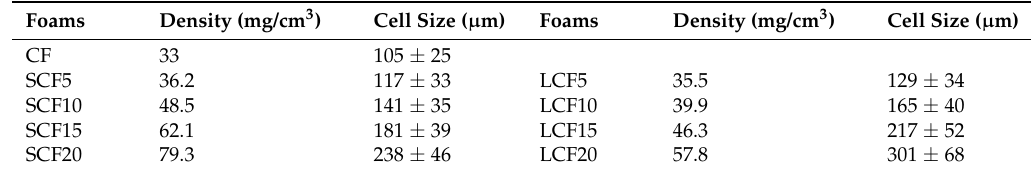
Figure 3. SEM images of the composite foams. ( a – c ) SCF15 at different magnification; ( d – f ) LCF15 at different magnification. Table 1. Density and cell size of the composite foams.